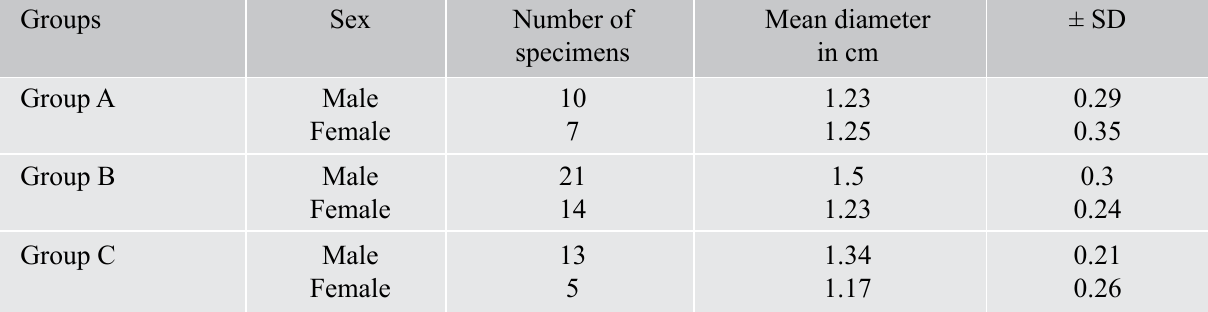
Table IV: Comparison of mean luminal diameter of the trachea between male and female